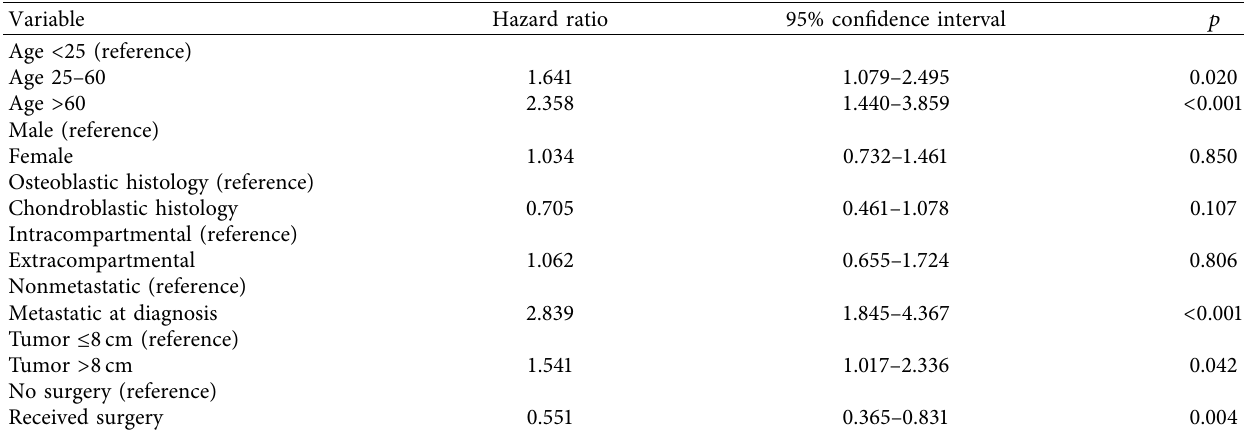
Table 2: Cox proportional hazards model.